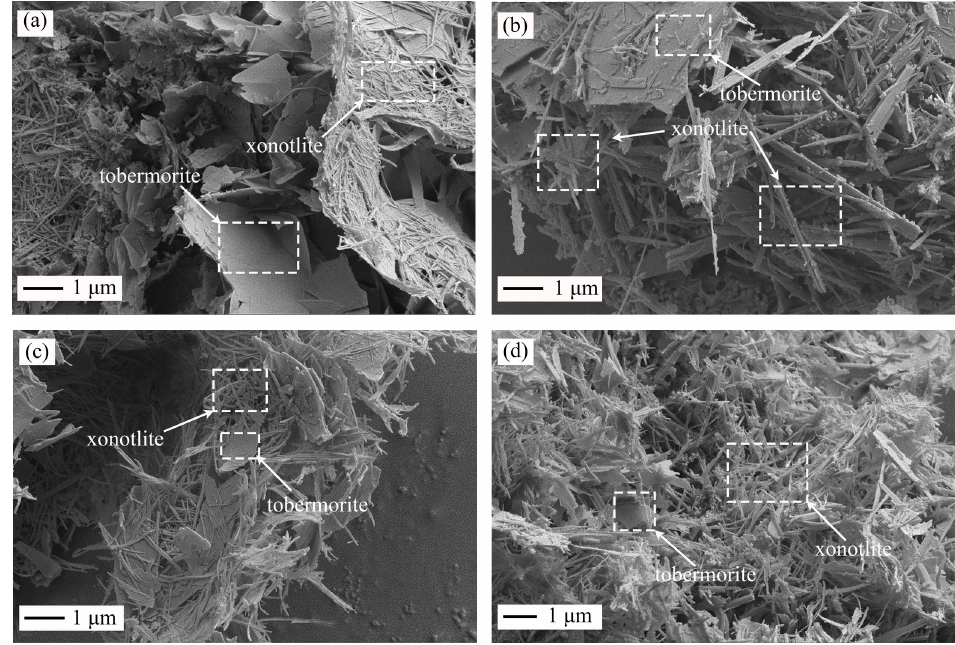
Figure 8. SEM images of the synthesis products from hydrated cement (M0) and calcined hydrated cement (M900) at 220 °C. Note: ( a ) M0-12 h, ( b ) M900-12 h, ( c ) M0-24 h, and ( d ) M900-24 h. cement (M900) at 220 ◦ C. Note: ( a ) M0-12 h, ( b ) M900-12 h, ( c ) M0-24 h, and ( d ) M900-24